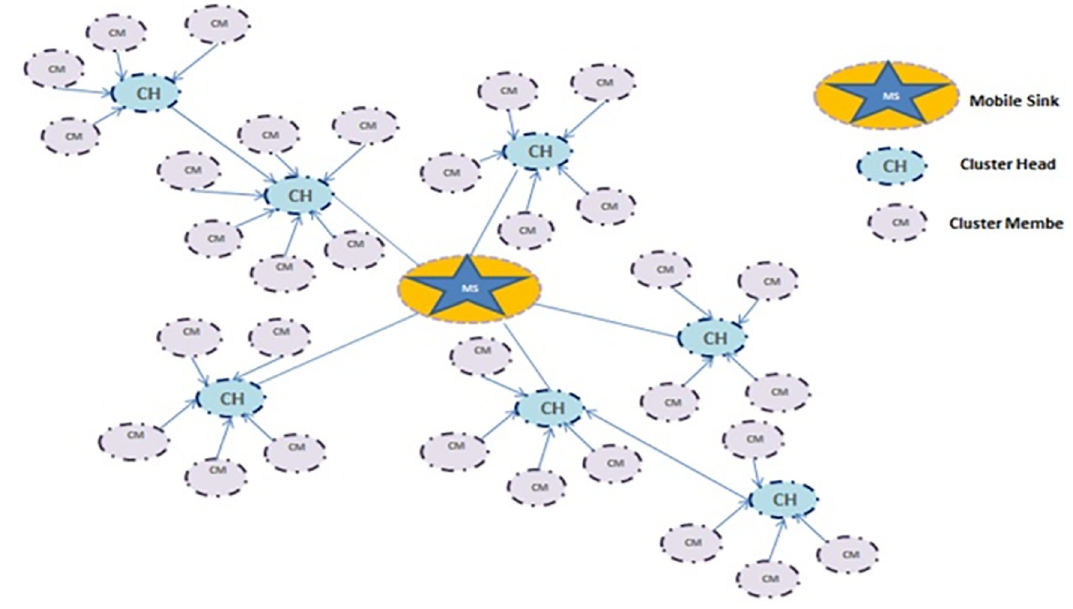
Fig 4. Platform configuration of the proposed method.